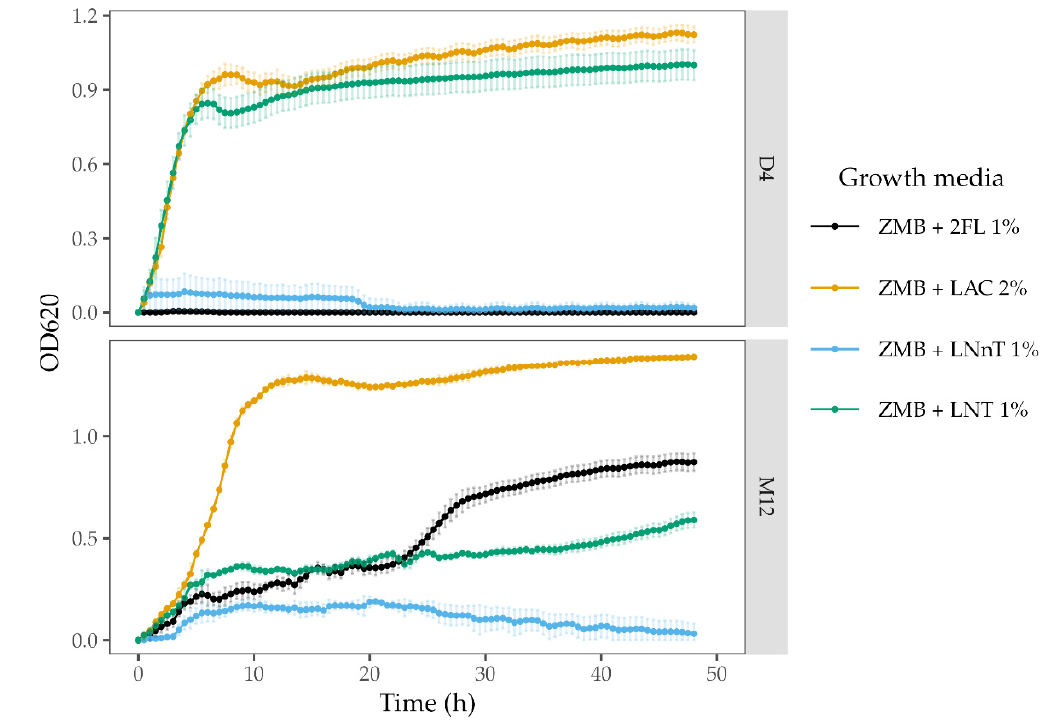
Figure 7. Growth curves of B. longum subsp. longum M12 and D4 inferred at 620 nm. The HMOs 2FL (2 ‐ Fucosyllactose), LNT (Lacto ‐ N ‐ tetraose), and LNnT (Lacto ‐ N ‐ neotetraose) were used as the only carbon source. Lac (Lactose) was used as a positive control.